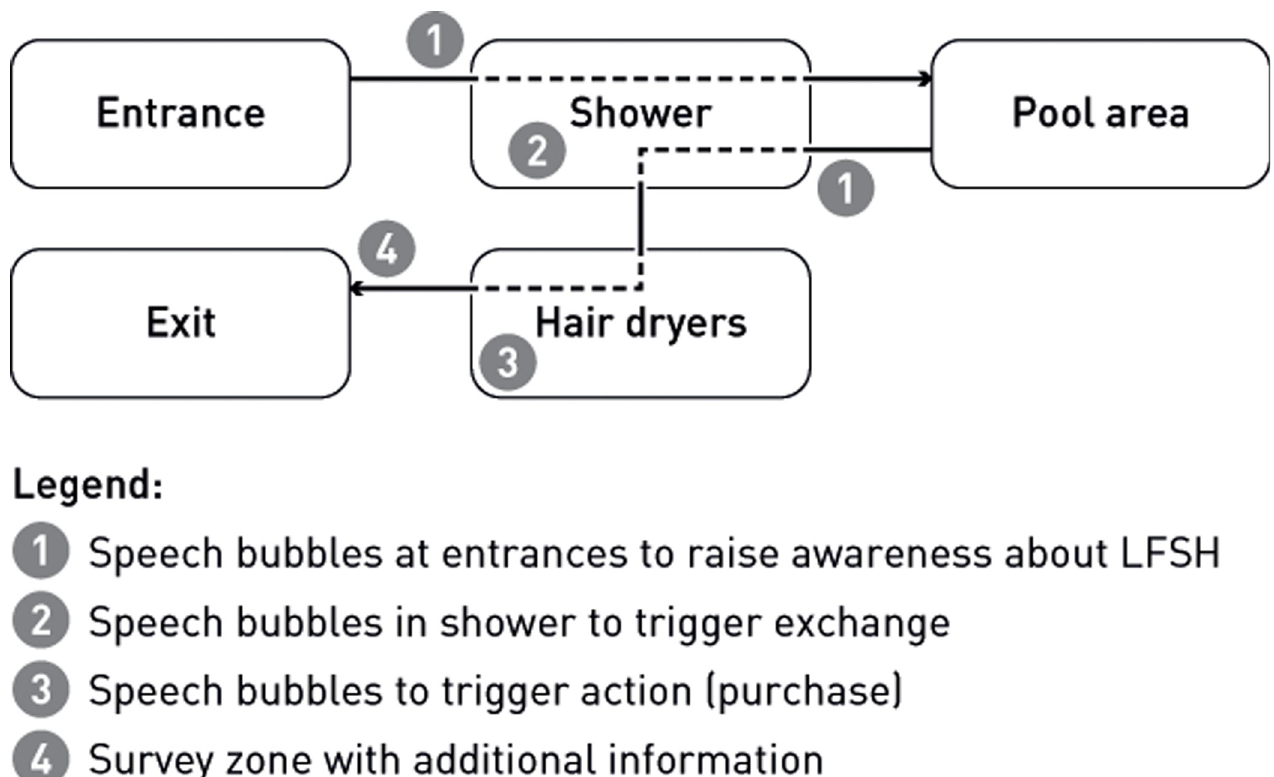
Fig 1. Information campaign in the public swimming